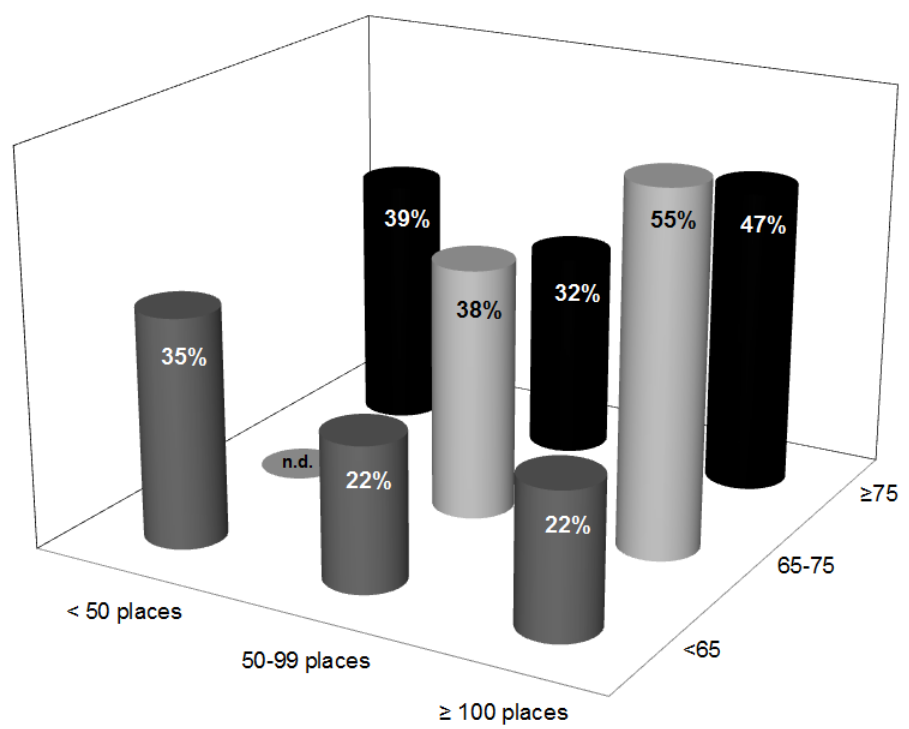
Figure 1. Average percentage of residents, indicated by column height, who had diarrhea at least once a year as function of nursing home size and average age of residents (total number of answers n = 55). Values were only calculated in cases where at least three answers were available for the respective size/age-category (n.d. = insufficient number of data).